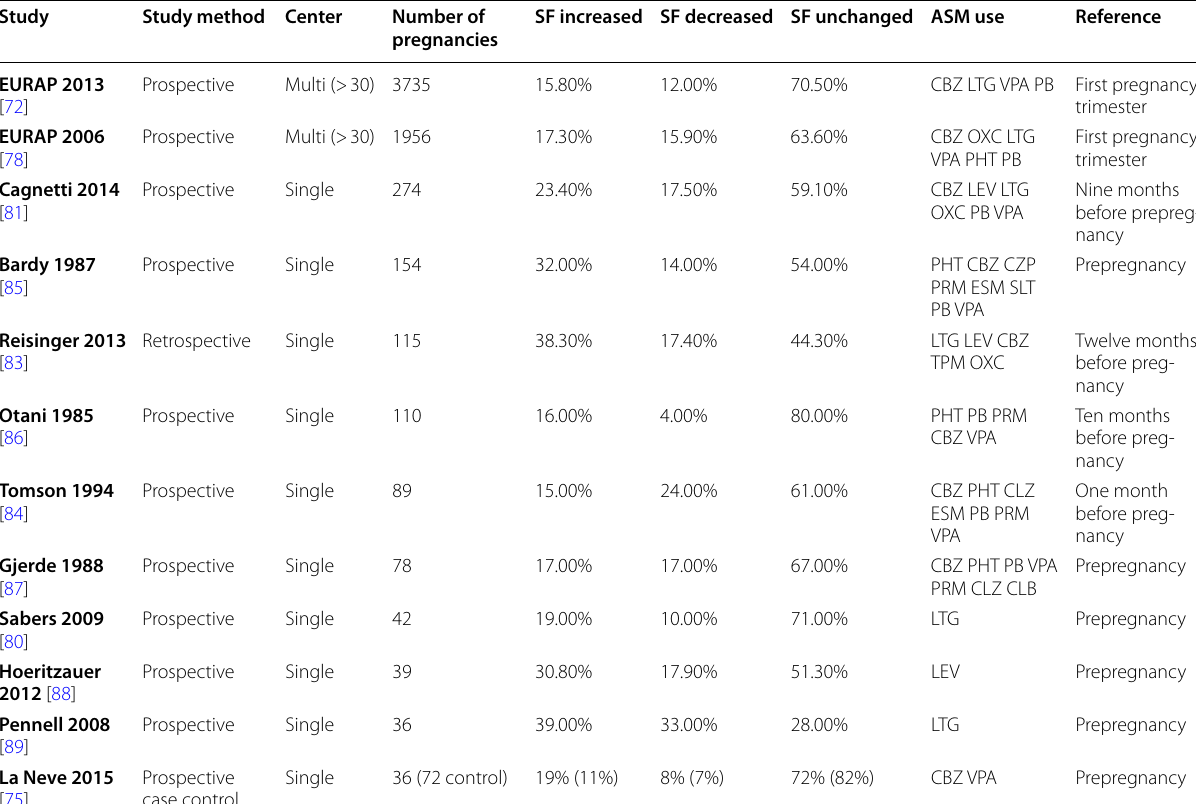
Table 4 Seizure frequency change in different